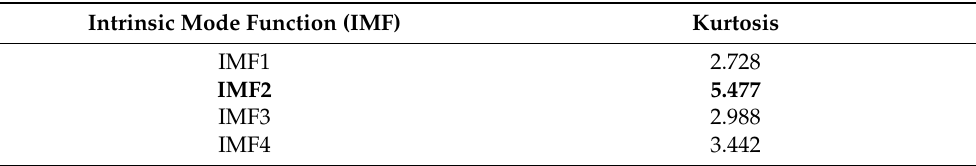
Figure 15. The first four IMFs of the five-speed transmission experiment signal: ( a ) IMF1; ( b ) Amplitude spectrum of IMF1; ( c ) IMF2; ( d ) Amplitude spectrum of IMF2; ( e ) IMF3; ( f ) Am- plitude spectrum of IMF3; ( g ) IMF4; ( h ) Amplitude spectrum of IMF4. Table 5. The kurtosis of the first four IMFs (the five-speed transmission